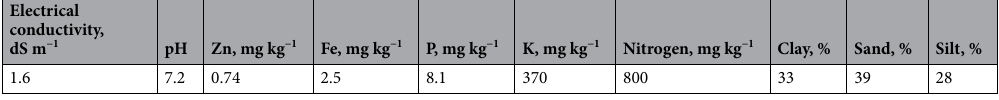
Table 4. Physical and chemical properties of experimental